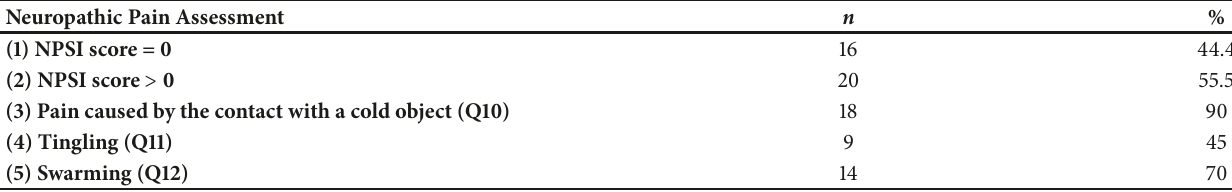
(a) Neuropathic Pain Assessment. (1) Number of patients without neuropathic pain (null NPSI score). (2) Number of patients with neuropathic pain (positive NPSI score). (3-5) Number of patients with positive response at questions 10, 11 and 12. NPSI: Neuropathic Pain Symptoms Inventory. Neuropathic Pain Assessment